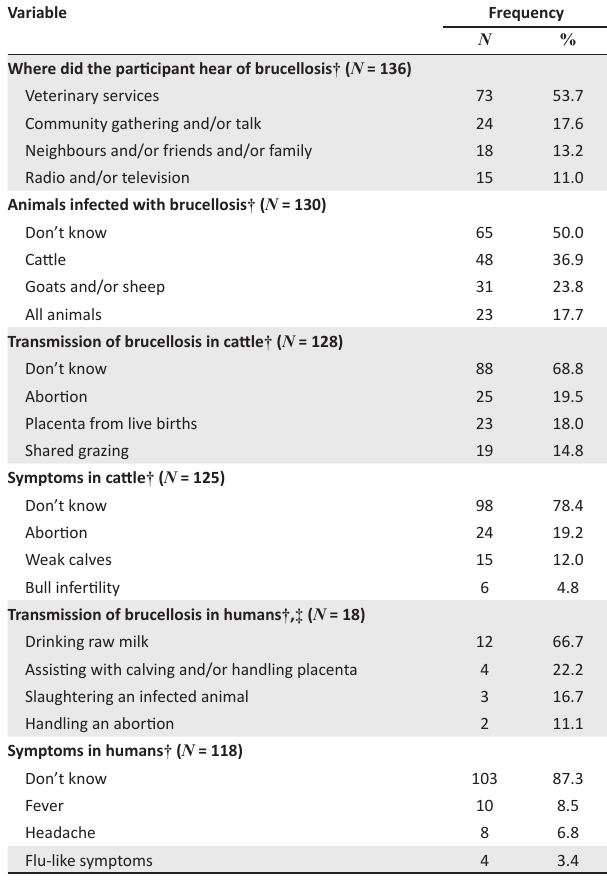
TABLE 1: Selected socio-demographic characteristics of cattle keeper households in the Whittlesea community, South Africa, 2017. Variable ( N specified because of missing data)